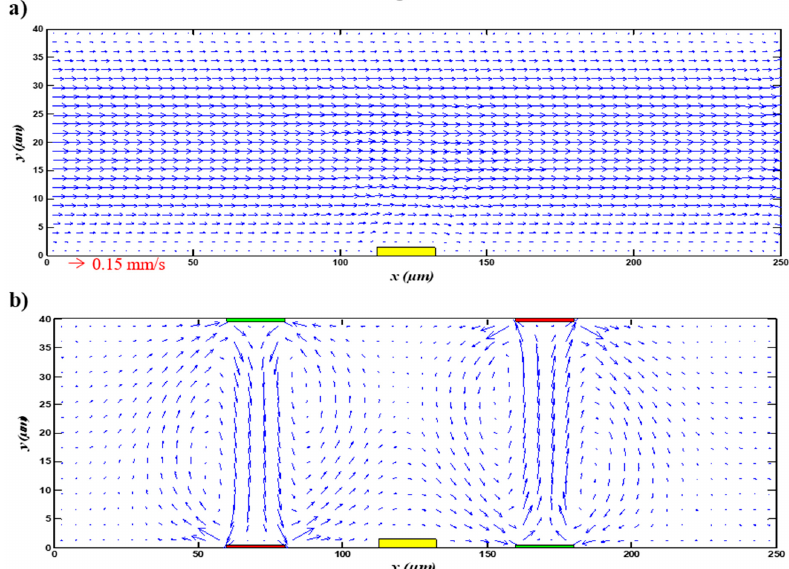
Figure 2. Velocity field ( a ) in the absence of an electric field and ( b ) in the presence of an applied electric field. electric field. Micromachines 2020 , 11 , x